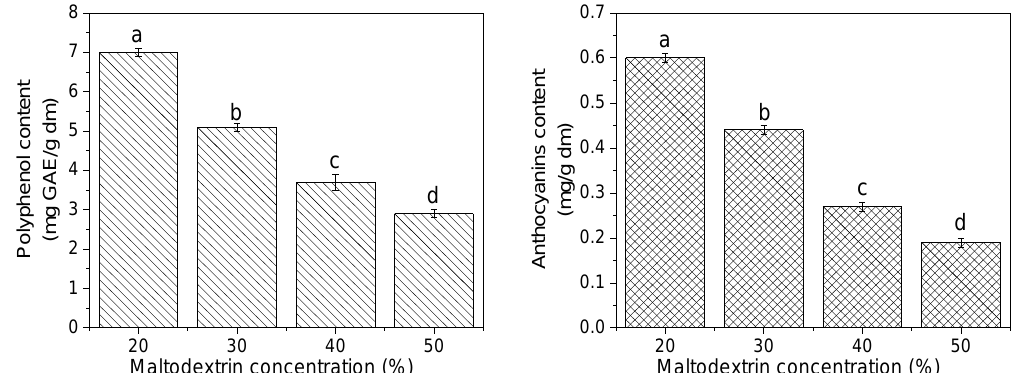
Figure 4. Total polyphenol content and total monomeric anthocyanin of freeze-dried Andean blueberry juice powders with different concentrations of maltodextrin. Values with different superscript letters are significantly different ( p < 0.05).